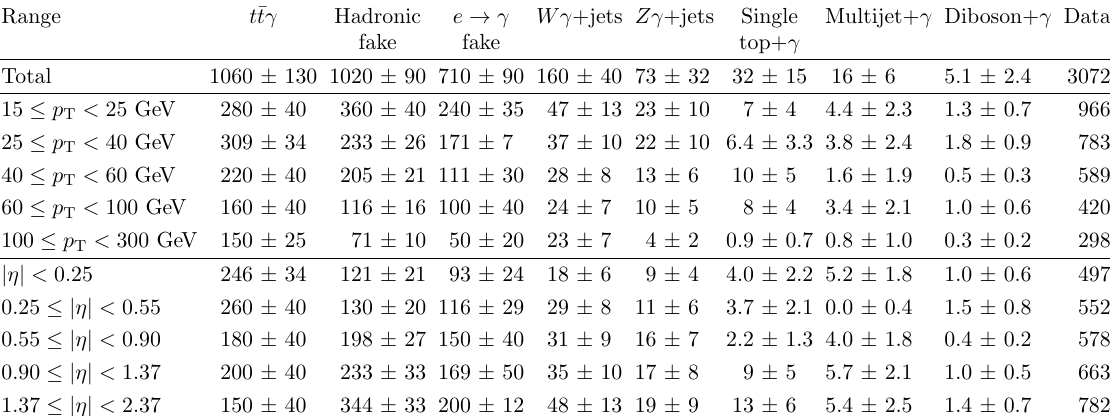
Table 3. Post-(cid:12)t event yields for the signal and backgrounds for the inclusive cross-section mea- surement and for the di(cid:11)erent bins of reconstructed photon p T and (cid:17) for the di(cid:11)erential cross-section measurement. The uncertainties include the statistical and systematic